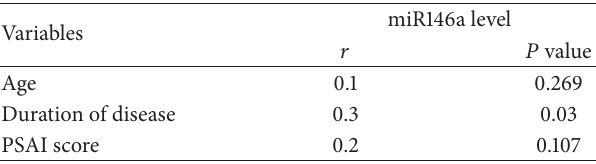
Table 4: Correlation between miR146a level before treatment and age, disease duration, and PASI score among all patients.